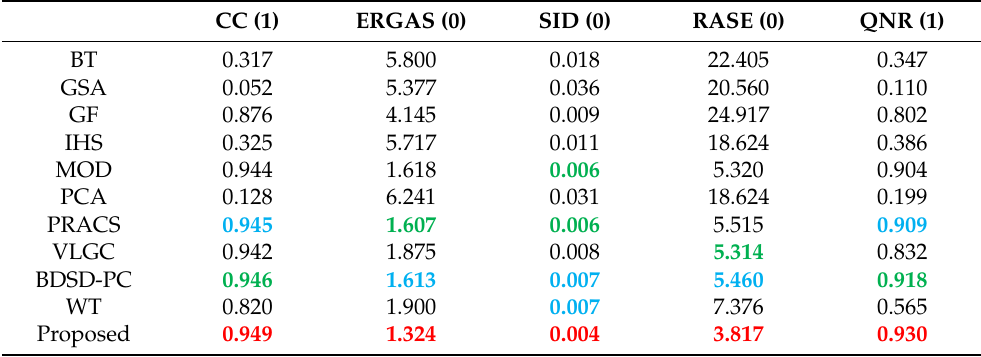
Figure 6. The fusion results of ten different methods on the first image pair: ( a ) BT; ( b ) GSA; ( c ) GF; ( d ) IHS; ( e ) MOD; ( f ) PCA; ( g ) PRACS; ( h ) VLGC; ( i ) BDSD-PC; ( j ) WT; ( k ) the proposed method; ( l ) the reference MS image. Table 3. Objective evaluation of the experimental results on the second image Table 2. Objective evaluation of the experimental results on the first image pair.